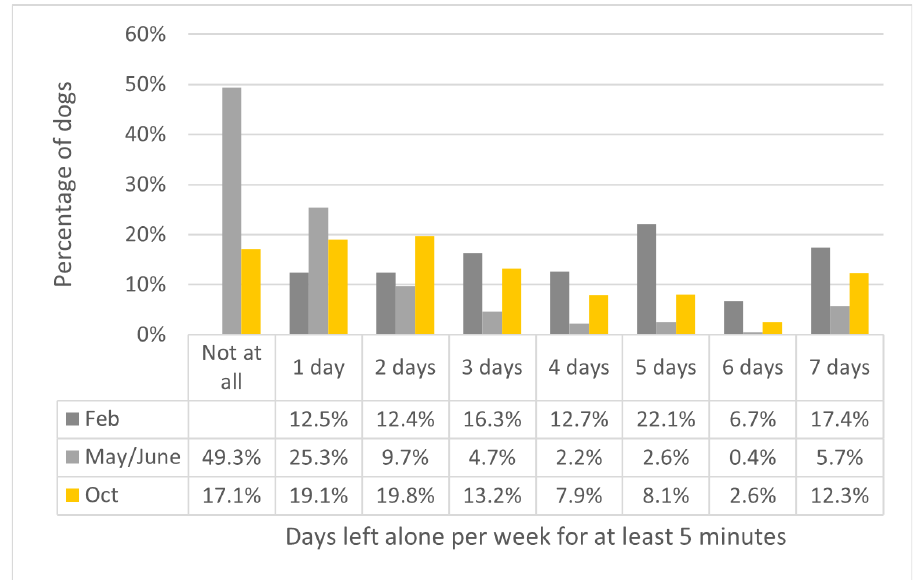
Figure 1. The percentage of dogs in the sample ( n = 1807) who were left alone for at least 5 min on a given number of days on average at baseline in February, in the previous 7 days for the May/June survey under ‘lockdown’ restrictions, and in the previous 7 days for the October follow-up survey. Dogs who were not left alone at all in February were excluded from this analysis.